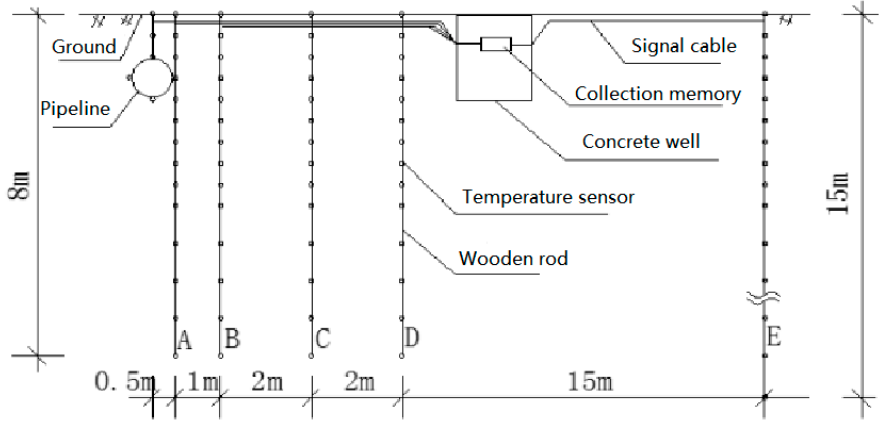
Figure 16. Site installation of temperature field monitoring